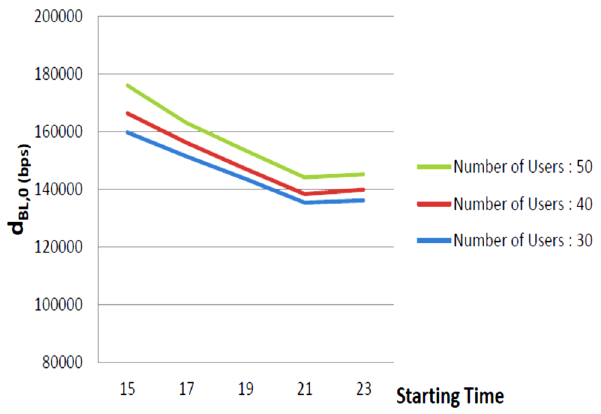
Figure 6. Starting time for pre ‐ scheduling vs. (cid:1856) (cid:3003)(cid:3013),(cid:2868) (UE velocity = 120 km/h, actual TTT = 25.981 s).